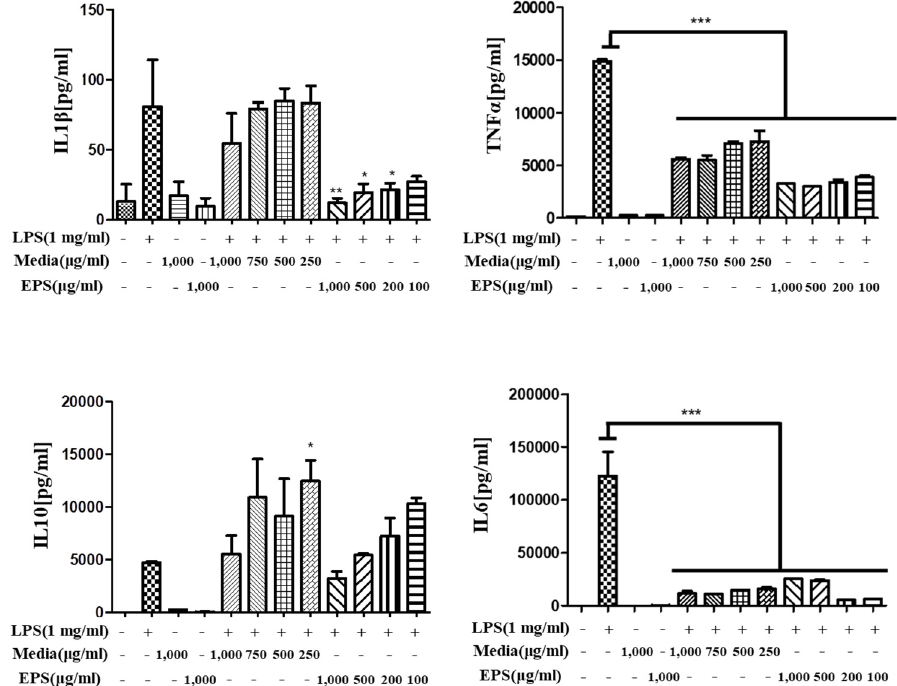
Figure 6. The expression levels of cytokines, induced by the treatment with L. fermentum KGC1601 in RAW 264.7 cells. Cytokines were quantified using ELISA. The four cytokines used for the experiment were TNF- α , IL-1 β , IL-6, and IL-10. Cells were pre-treated with L. fermentum KGC1601-cultured media and isolated EPS. EPS inhibited the LPS-induced inflammatory response in RAW 264.7 cells. * p < 0.05, ** p < 0.01, and *** p < 0.0001 versus the LPS-treated group.